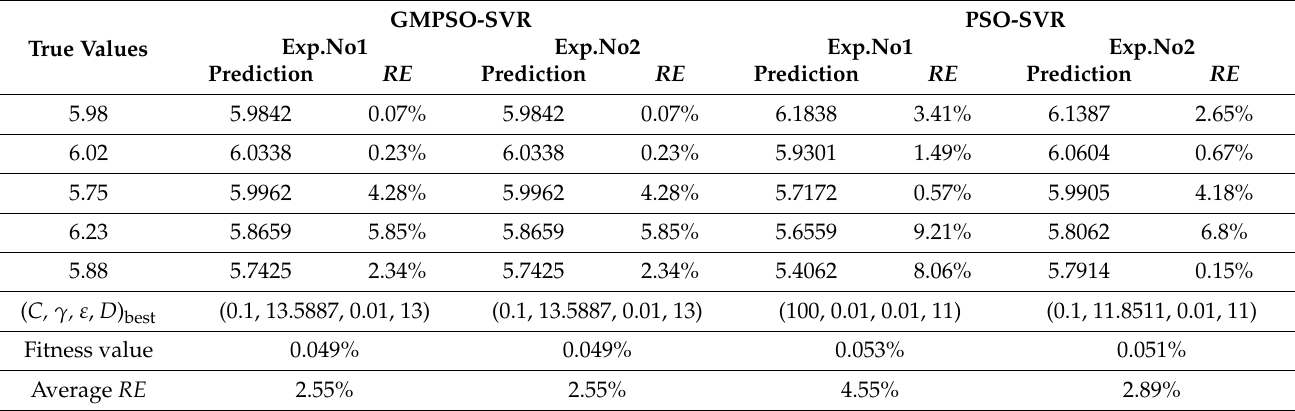
Table 3. Comparison of multi-step prediction results.